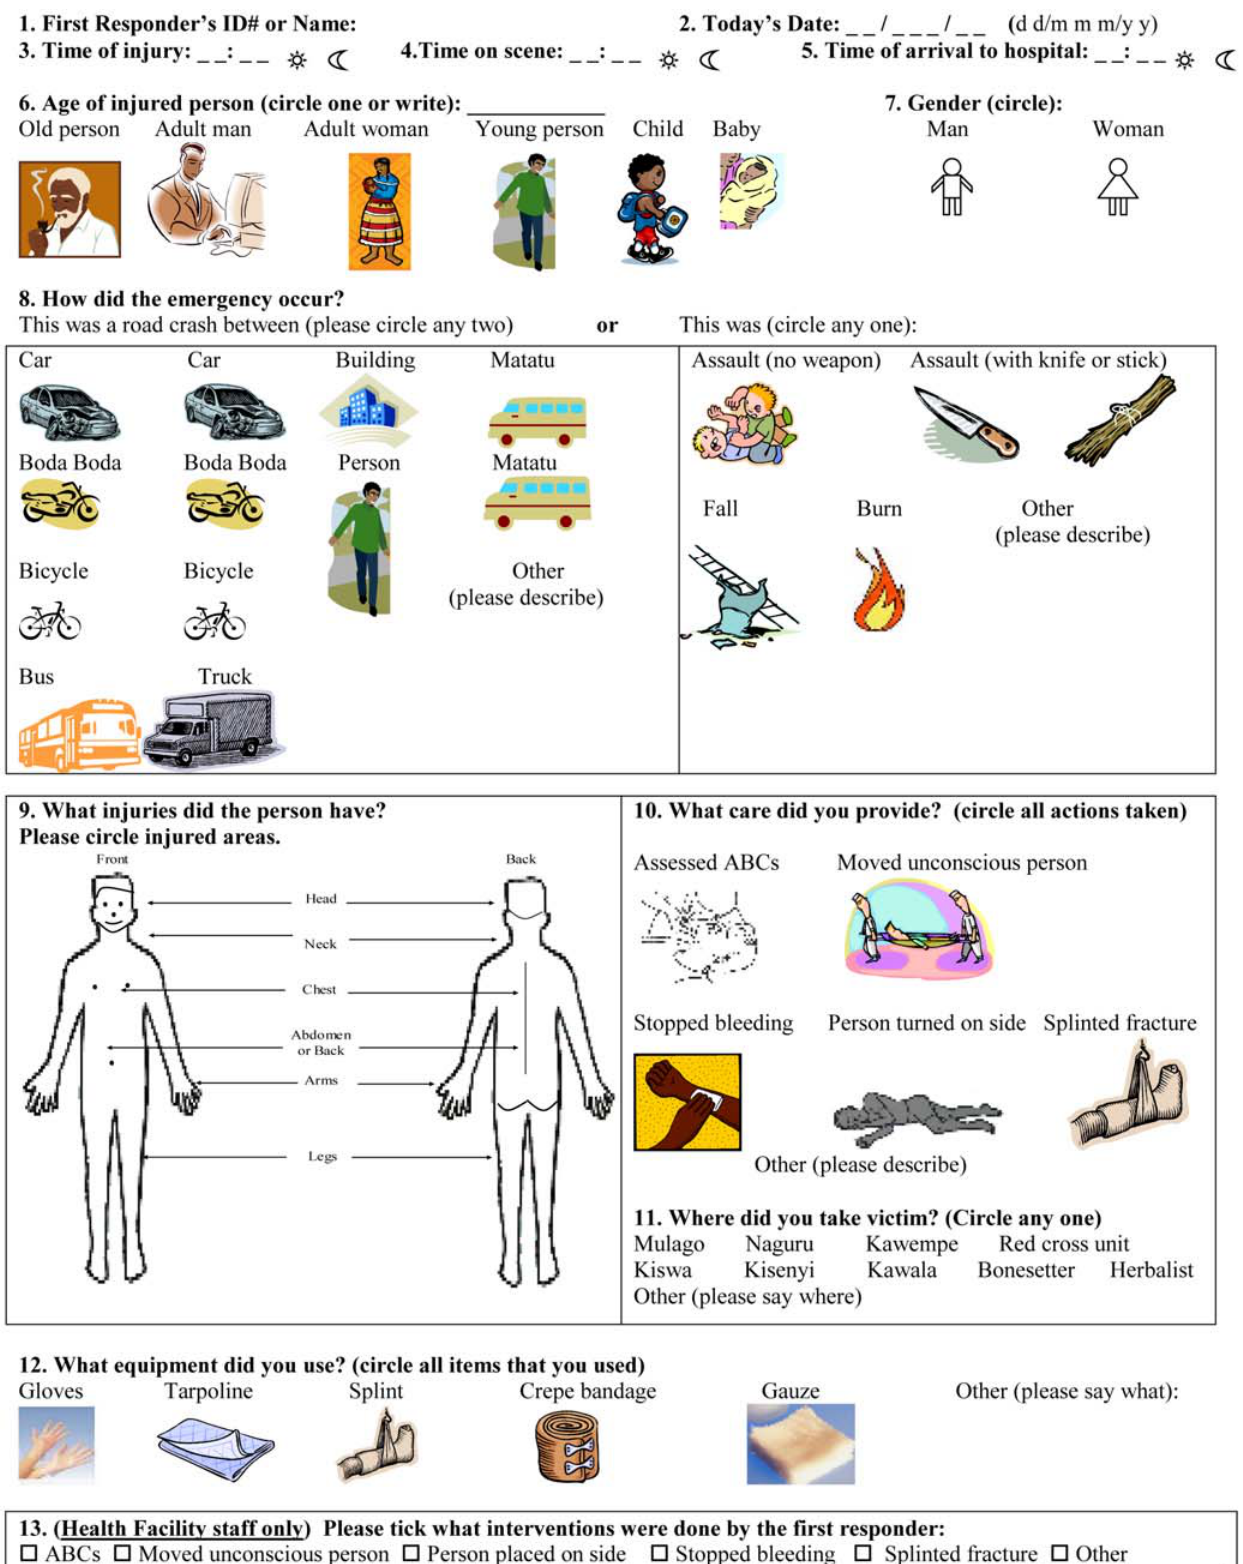
Figure 1. Prospective Data Collection Form for First Responders.